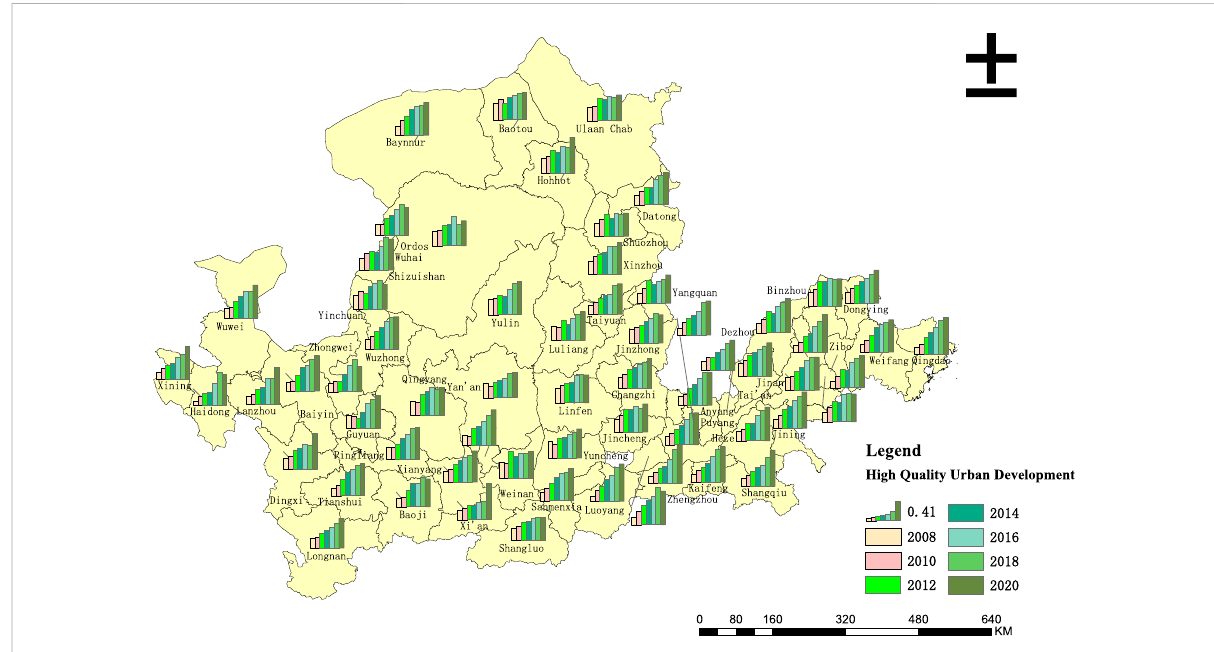
FIGURE 1 Spatial and Temporal Distribution of HQD Index of 62 Cities in the YRB. Note: The plotted data are derived from the results measured based on Eq.2.ThespatialandtemporaldistributionsinthispaperaregeneratedthroughArcGIS10.5.ThesourcesofthevectordiagramoftheYRBcamefrom the National Geomatics Center of China (NGCC).